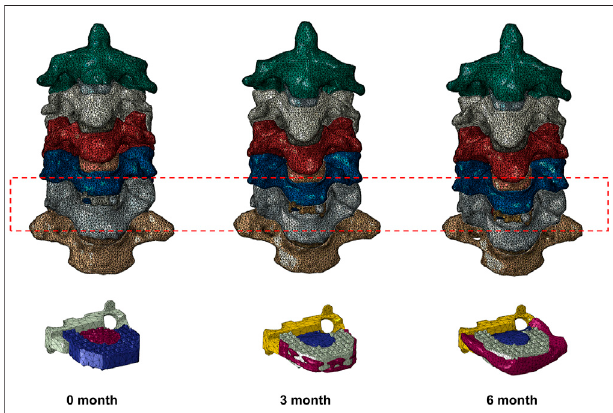
FIGURE 1 | Finite element models of a patient who underwent anterior cervical discectomy and fusion at C5/6 0, 3, and 6 months after surgery with different fusion